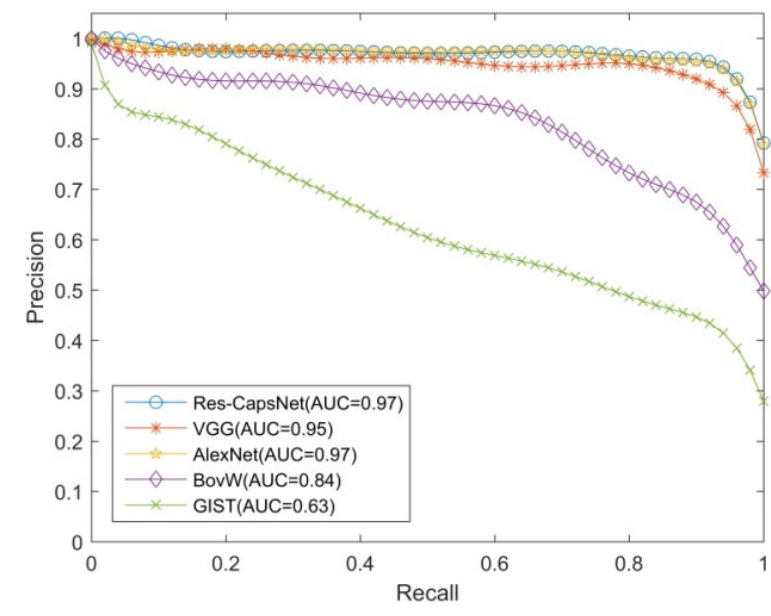
Figure 9. Precision–recall curves of the day ‐ left vs. day ‐ right datasets.